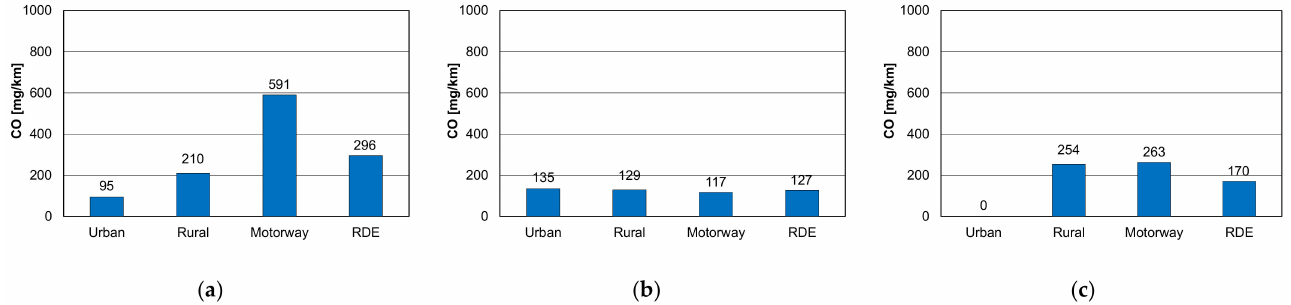
Figure 9. Results of tests of carbon monoxide emission in a passenger vehicle with a gasoline engine ( a ), a diesel engine ( b ), PHEV ( c